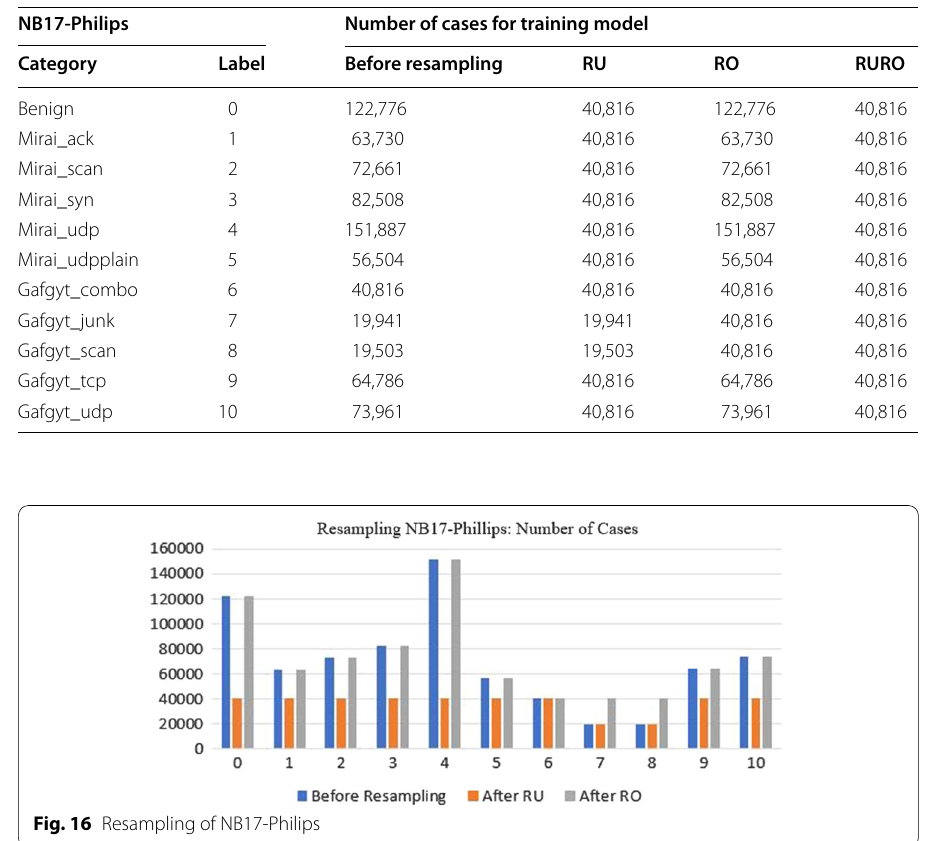
Table 43 Resampling of NB17-Philips